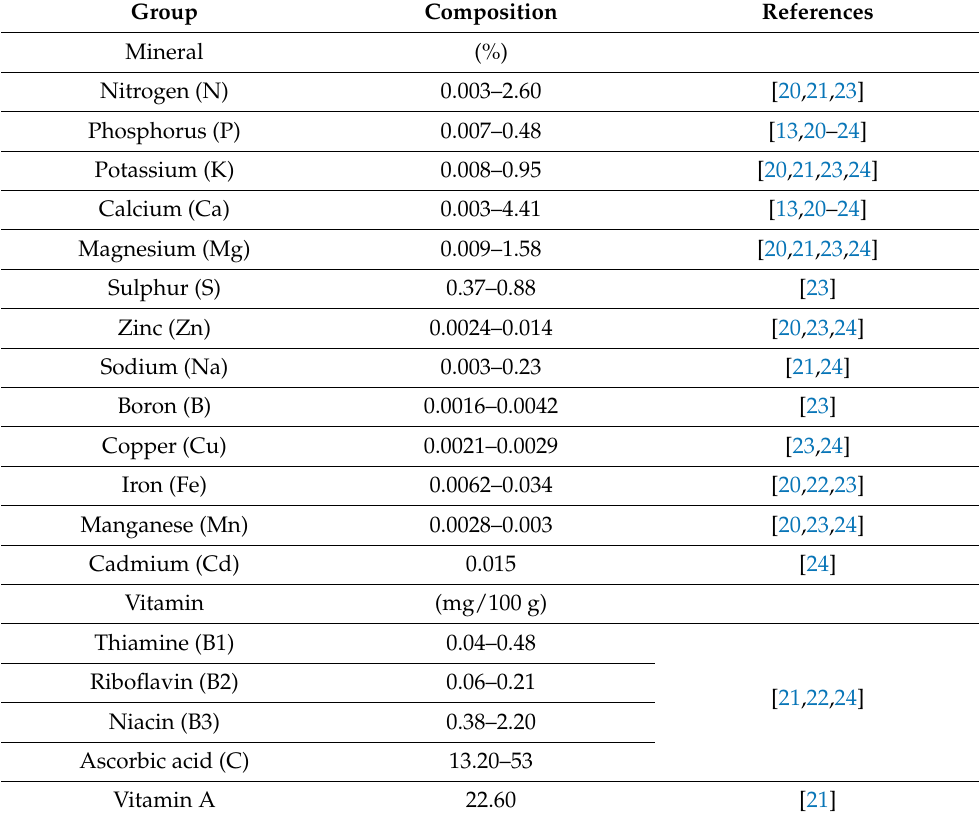
Table 2. Mineral and vitamin composition of mango